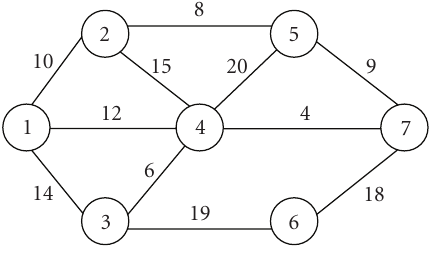
Figure 3.1 . A network with 7 nodes and 11